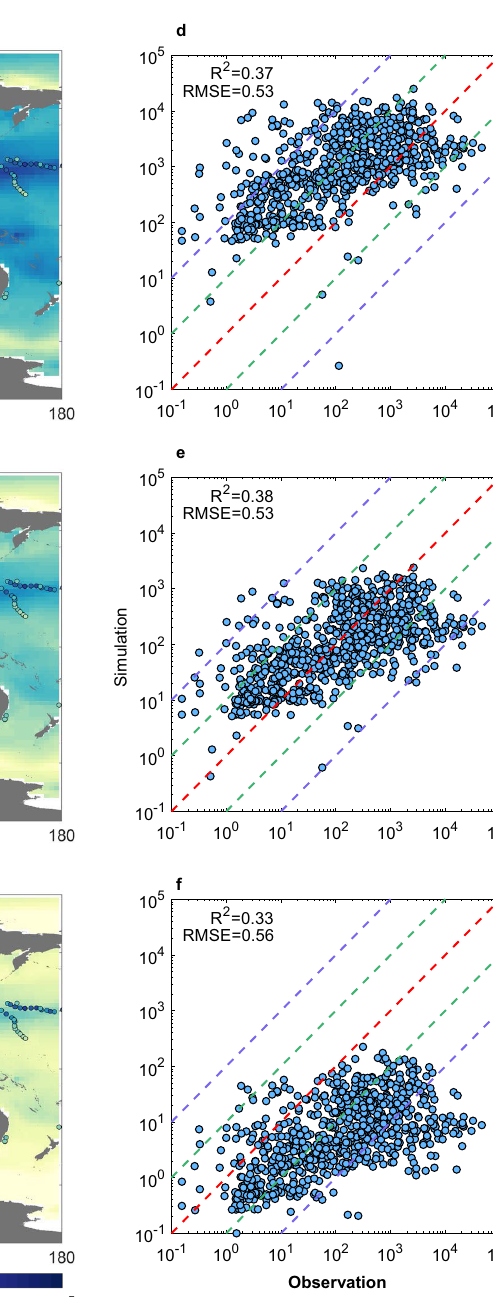
panels d – f , the dashed lines are 100:1, 10:1, 1:1, 1:10, and 1:100. All the concentra- tions and the calculation of R 2 and RMSE are in a base 10 logarithmic scale with a unit of gkm − 2 . Sources of observation data are listed in Supplementary Table